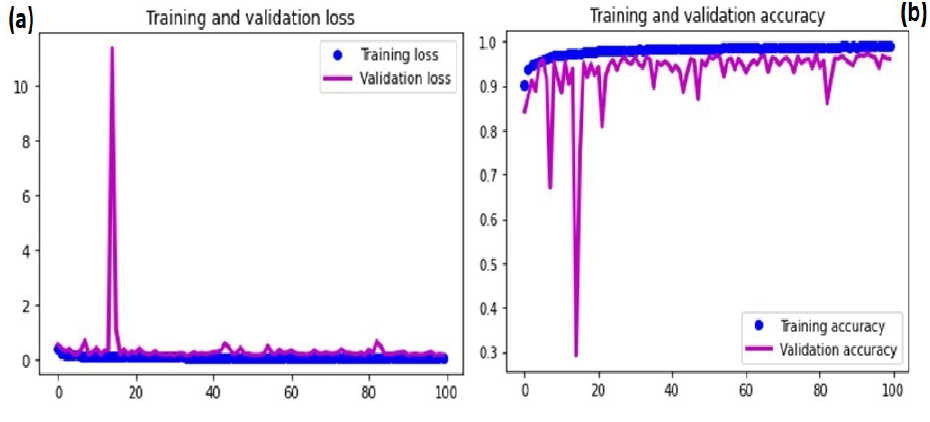
Figure 8. Stage I DCAE-CNN classification model convergence based on loss and accuracy :